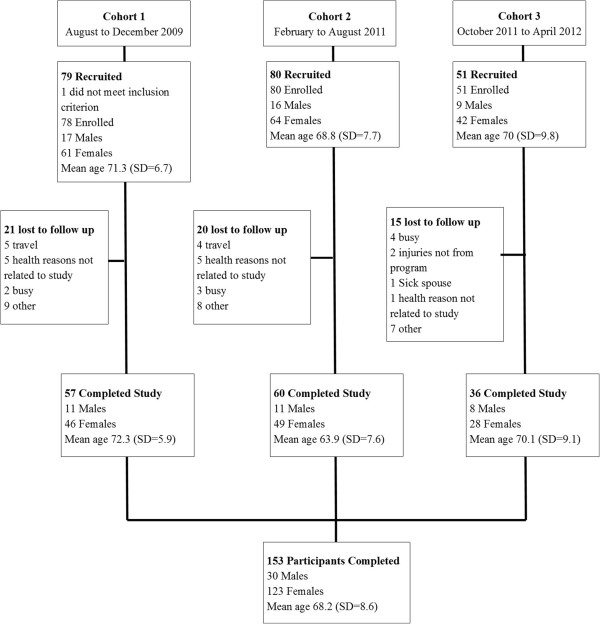
Flowchart of study.